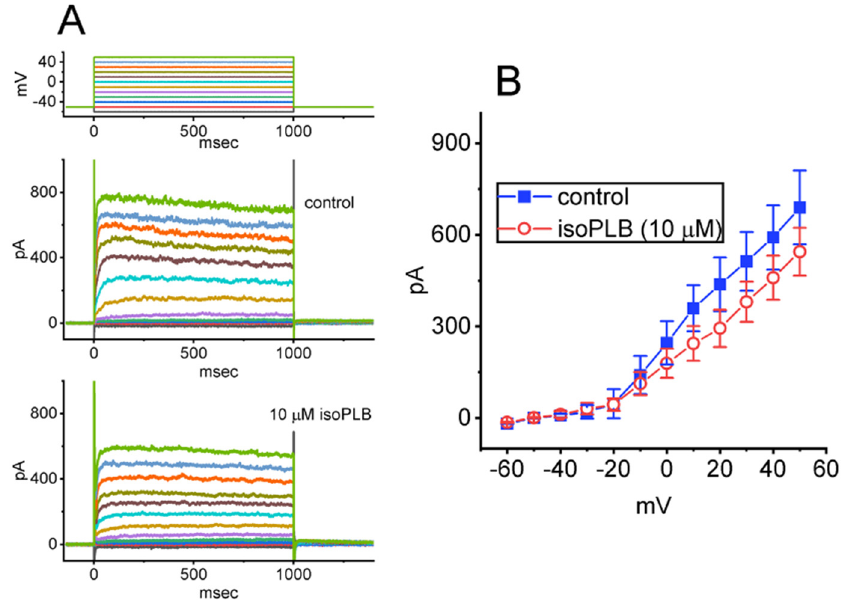
Figure 7. Inhibitory effect of isoPLB on delayed-rectifier K + current ( I K(DR) ) inherently in GH 3 cells. The experiments were performed as cells were bathed in a Ca 2+ -free Tyrode’s solution which contained 1 μ M TTX and 0.5 mM CdCl 2 , while the recording pipette was filled with a K + -enriched solution. The examined cell was maintained at − 50 mV and we imposed a series of 1-sec step commands ranging between − 60 and +50 mV in 10-mV step. ( A ) Representative current traces obtained in the control period (i.e., absence of isoPLB) (upper) and during cell exposure to 10 μ M isoPLB (lower). The uppermost part shows the voltage-clamp protocol used. ( B ) Average I–V relationships of I K(DR) taken in the absence (solid blue squares) and presence of 10 μ M isoPLB (open red circles) (mean ± SEM; n = 7 for each point). We measured the current amplitude at the end of each step voltage-clamp command. Of note, cell exposure to 10 μ M isoPLB results in the mild inhibition of the I K(DR) amplitude measured over the entire voltage-clamp range imposed. The analyses in the absence and presence of isoPLB among different levels of membrane potentials were performed with ANOVA-1 ( p < 0.05).